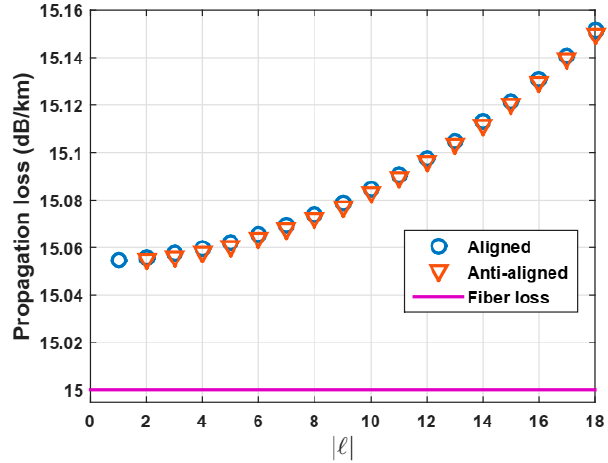
Figure 8. Propagation losses for OAM